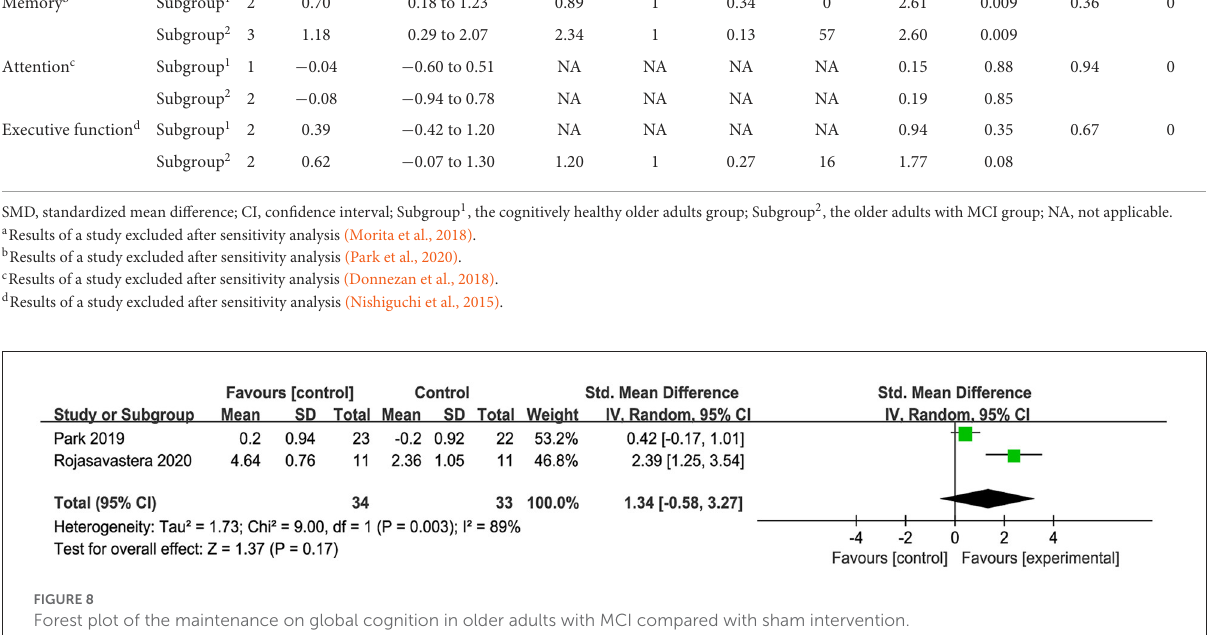
Test for effect subgroup 1,2 differences